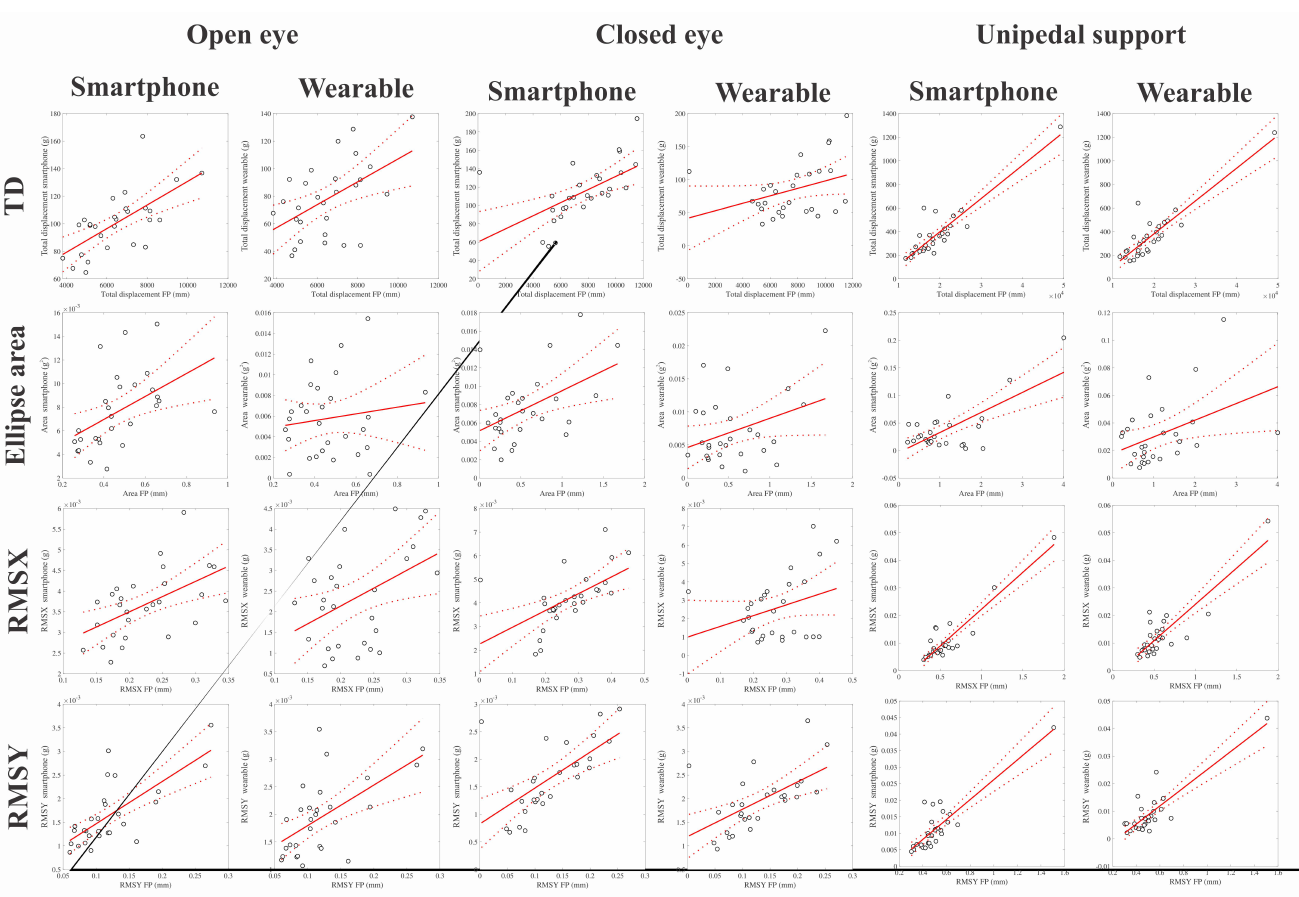
Figure 5. Correlation plots between the measurements obtained by force platform (x-axes) and inertial devices (y-axes). Continuous red lines represent the linear correlation and dashed red lines represent the confidence interval of the